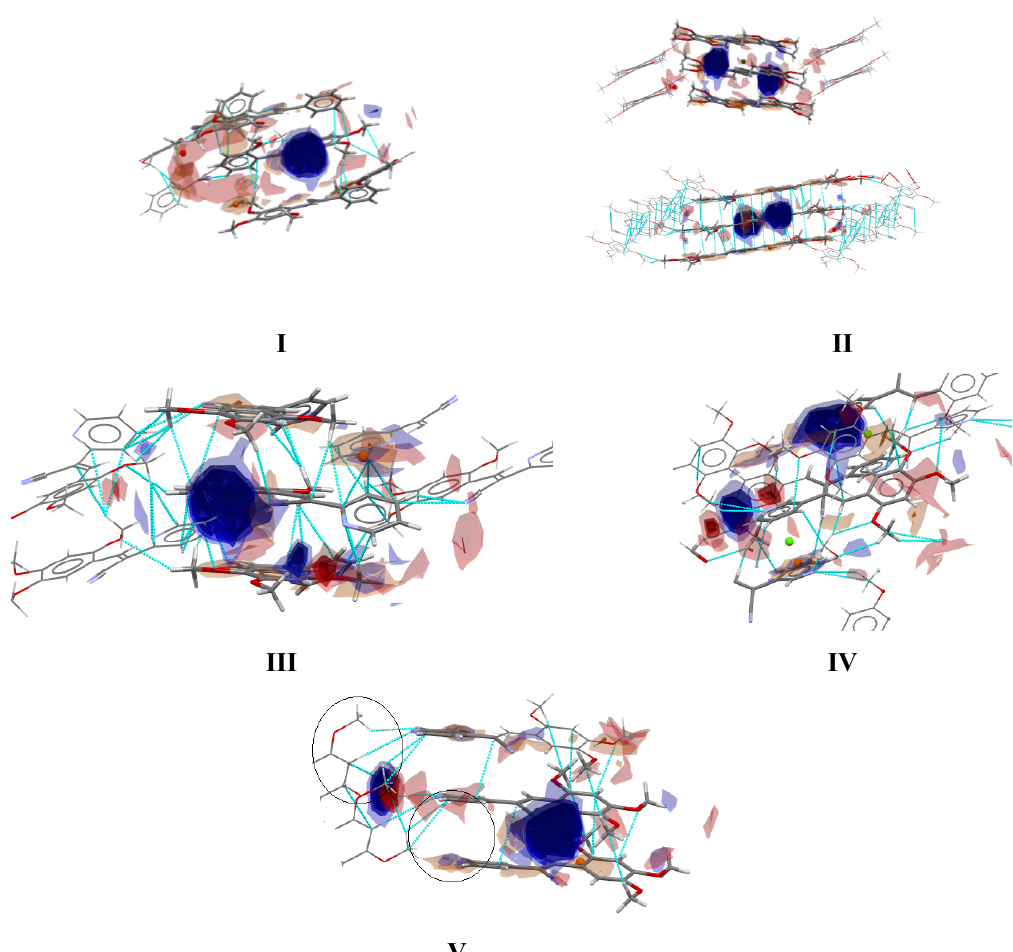
Figure 14. Interaction maps shown within packing patterns in the crystal structures of forms I – V . Regions of acceptor likelihood are shown in red, donors in blue and hydrophobic groups in brown.